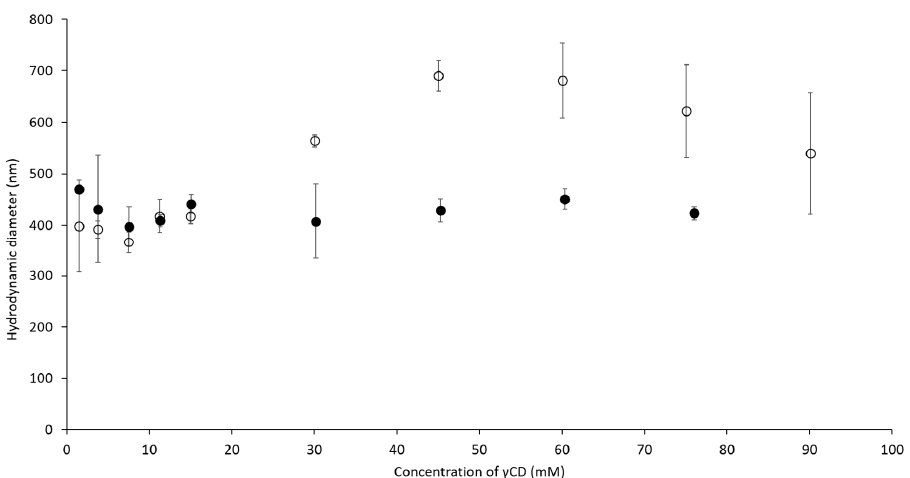
Figure 3. Hydrodynamic diameters of self-assembled γ CD molecule ( ) and AA/ γ CD inclusion complex in aqueous solutions ( ).